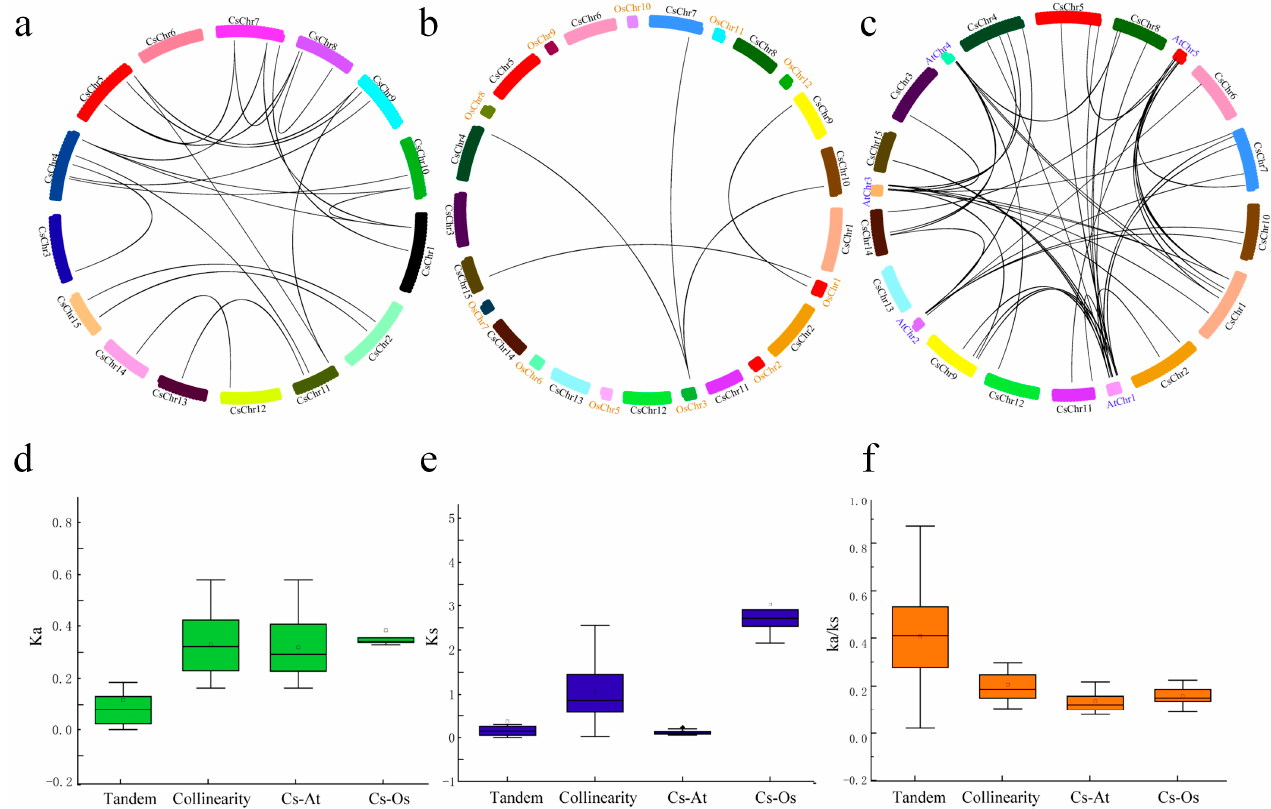
Figure 4. Genomic locations of Cs2ODD − C genes and segmentally duplicated gene pairs in the C. sinensis genome ( a ) and the orthologous relationships of Cs2ODD − C genes with O. sativa ( b ) and Arabidopsis ( c ). The chromosome number is indicated at the top of each chromosome. Ka ( d ), Ks ( e ), and Ka/Ks ( f ) ratio of segmental duplicate genes and orthologous genes among C. sinensis , O. sativa and Arabidopsis . The box plots exhibit the distributions of Ka, Ks, and Ka/Ks values among paralogs and orthologs. The small square and the line in the box represent average and median values of the Ka, Ks, and Ka/Ks values, respectively. Cs, C. sinensis ; Os, O. sativa ; At, Arabidopsis .